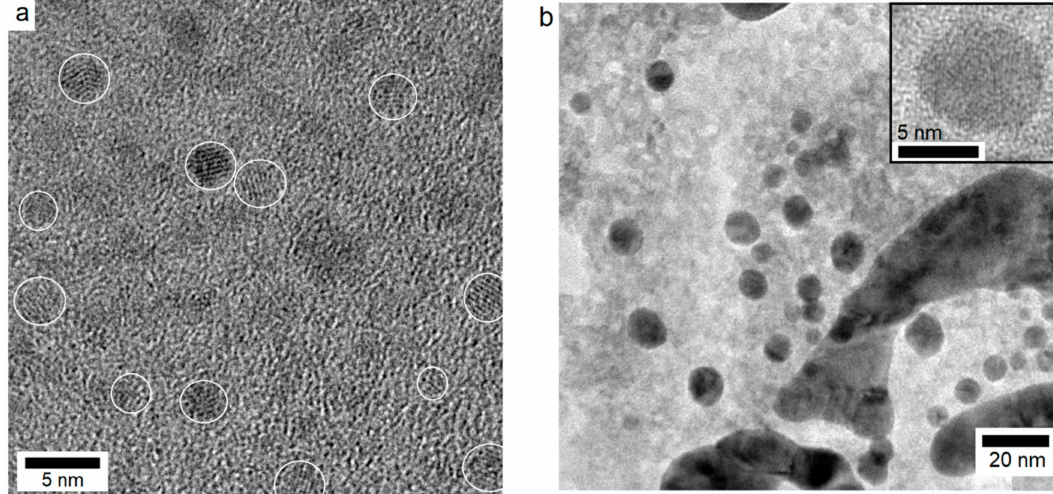
Figure 5. TEM microstructures of the samples S 6 and S 7 (Table 1) showing the NP size dependence on the EC reduction time in 1 mM CoSO 4 0.5 M H 3 BO 3 solution: ( a ) 5 s and ( b ) 20